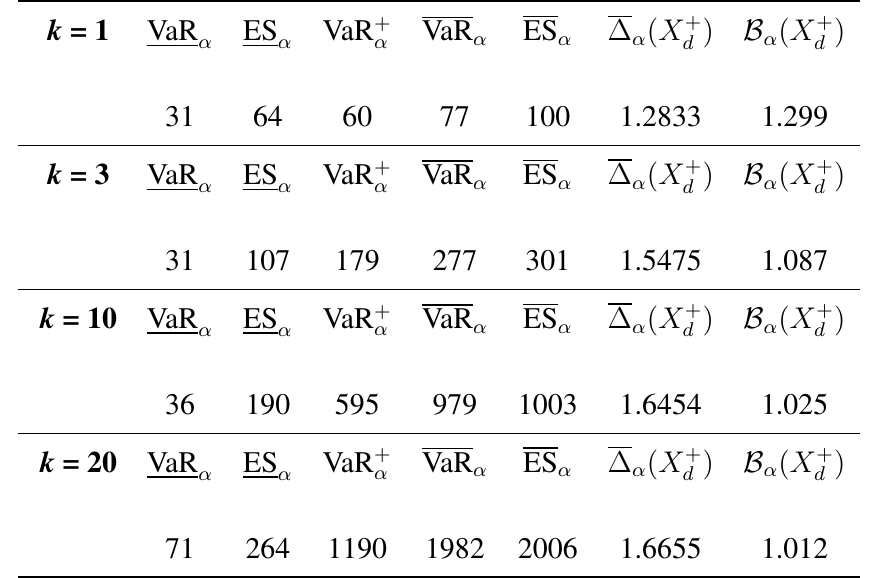
Table 5. Values (rounded) for best and worst VaR and ES for a inhomogeneous portfolio divided into three homogeneous subgroups, i.e., d = 3 k having marginals distributed